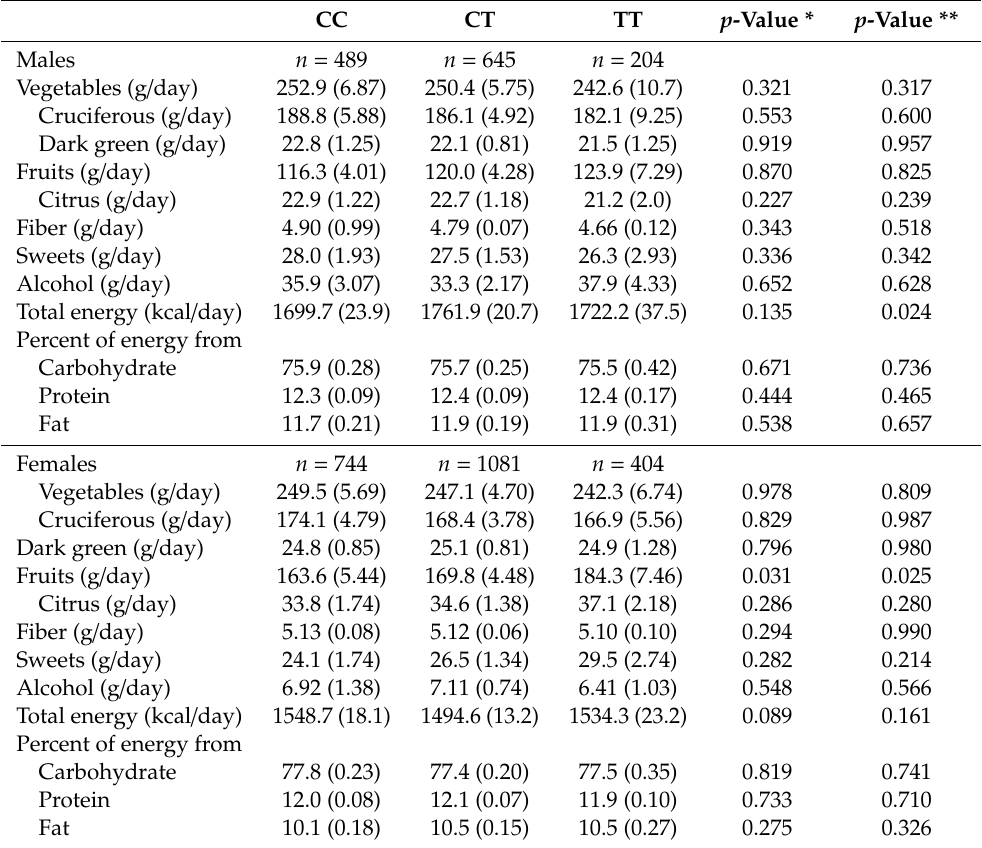
Table 2. Mean intake of selected food groups and alcohol taking into account the TAS2R38 rs10246939 genotype and